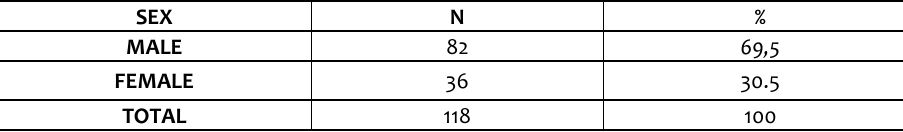
Table 1. Distribution of Obese Participants by Sex SEX N